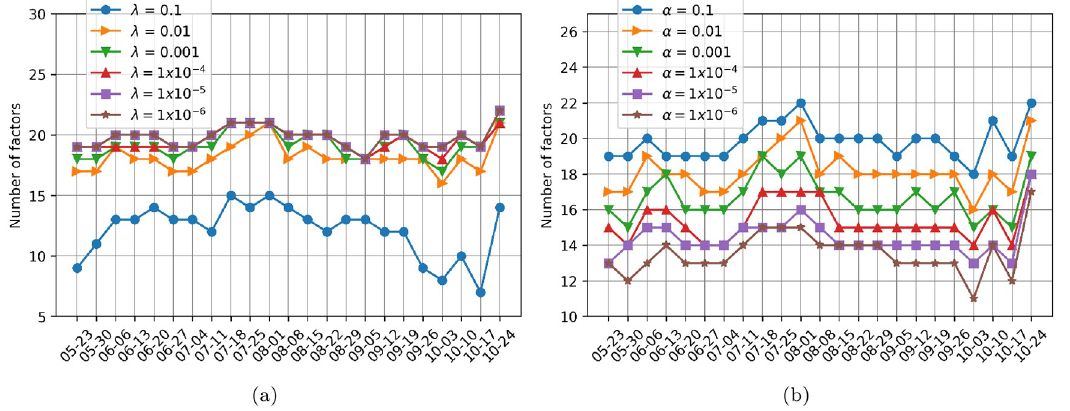
Fig 7. Number of factors as a function of time. Estimated factors for subsample data matrices over four weeks with a moving window of one week. (a) The level of significance is set at α = 0.01, and the regularization parameter λ is varied. (b) The regularization parameter is set at λ = 0.01, and the significance level α is